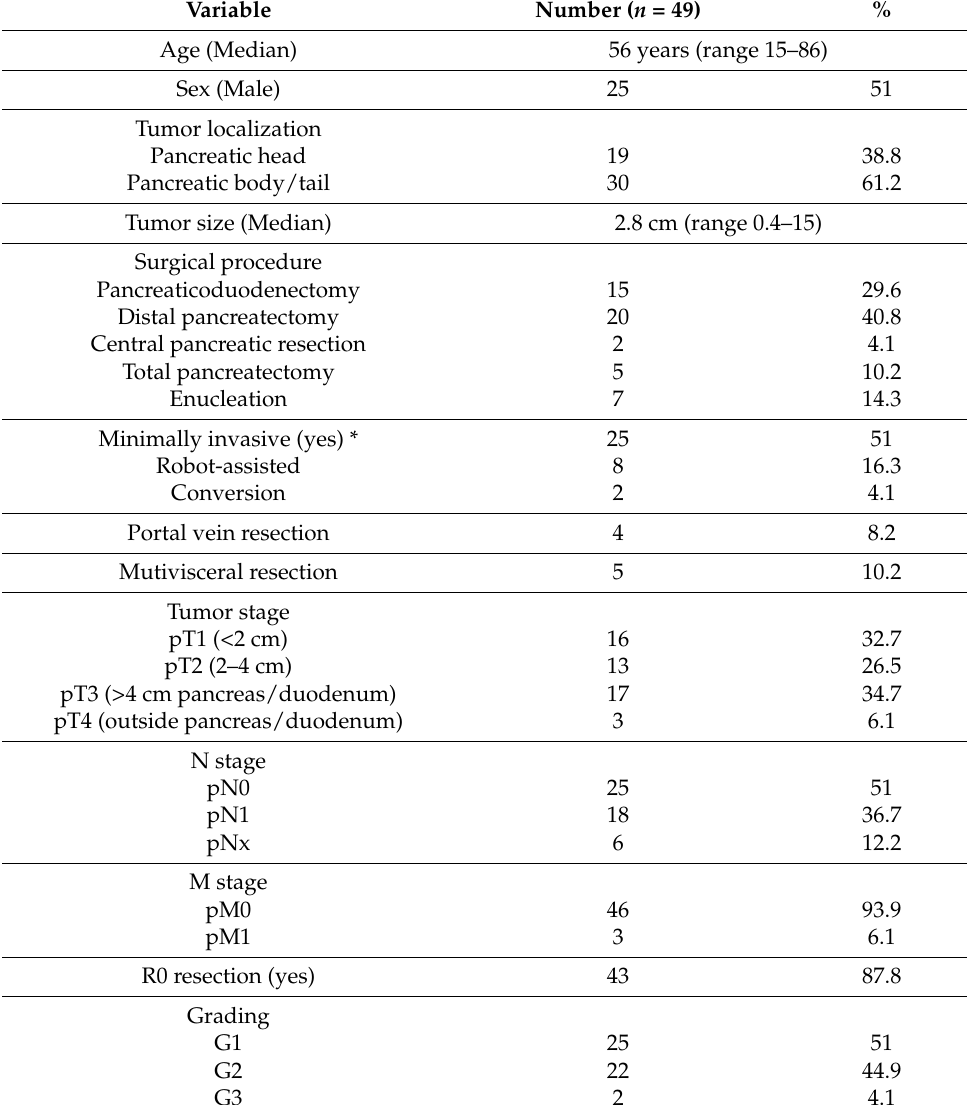
Table 2. Demographic and clinicopathological characteristics of the overall